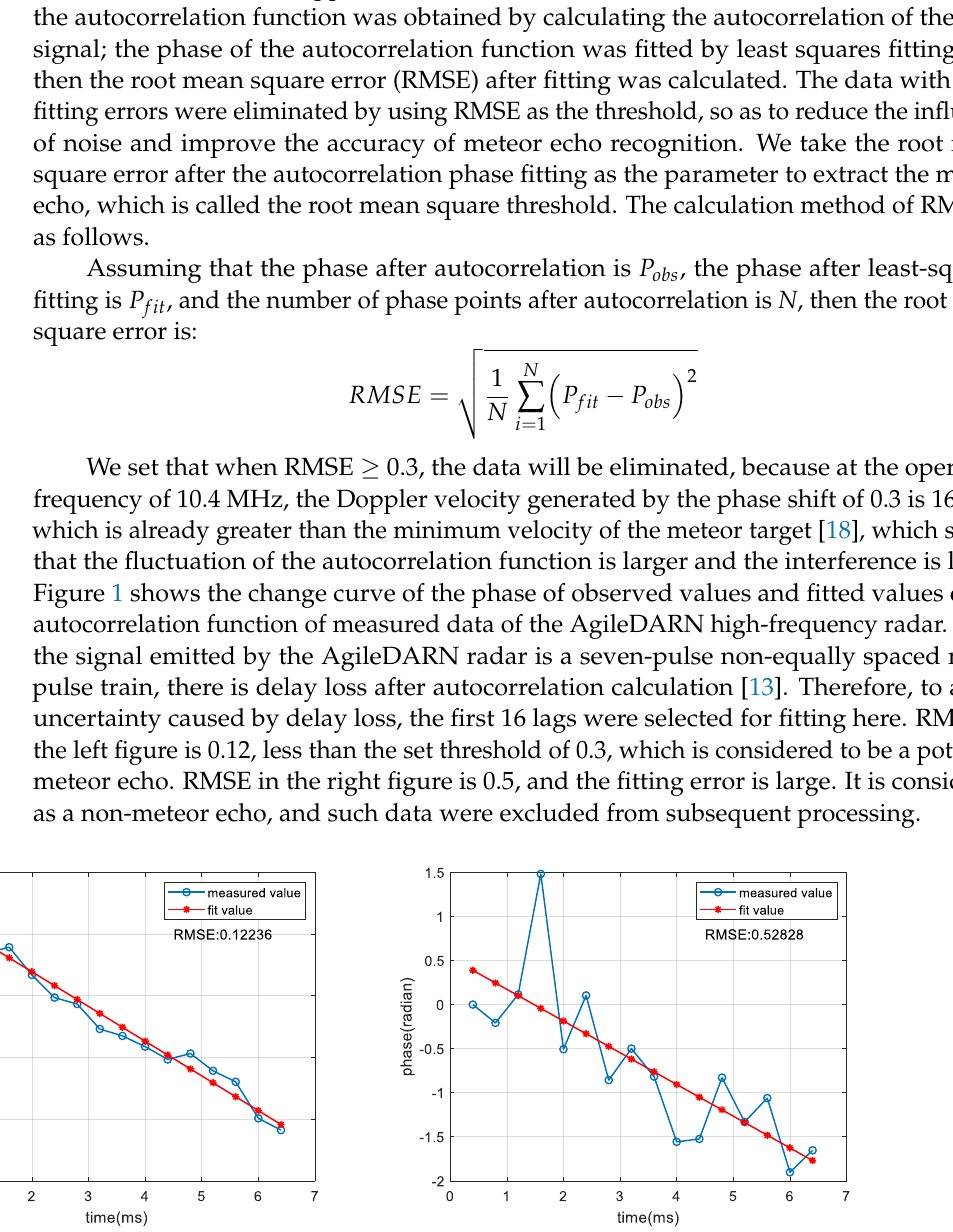
Figure 2. Phase fitting with RMSE below threshold, but not the meteor echo. According to the analysis of the velocity of the meteoroid, the velocity of the meteor- oid entering the Earth ’ s atmosphere was about 11~72 km/s, and there was almost no de- celeration in the process of the meteoroid ablating [1,20,21]. Thus, according to the veloc- ity of the meteoroid combined with Equation (3), the phase slope of the ACF was between 4.8 and 32.1. assuming that the initial phase is 0, the phase change was between 28.8 and 192.6 degrees, that is, between 0.5 and 3.4 radians. Considering that the Doppler velocity of the meteor target observed by radar is the meteor velocity component, combined with the velocity characteristics of the meteor target observed by SuperDARN [21], the phase change value of less than 0.3 radian after selecting the phase fitting of the autocorrelation function was considered not to be the meteor echo, and the data were eliminated without subsequent processing. For the convenience of later discussion, this threshold is called the phase change, that is, data with a phase change of less than 0.3 radian are regarded as